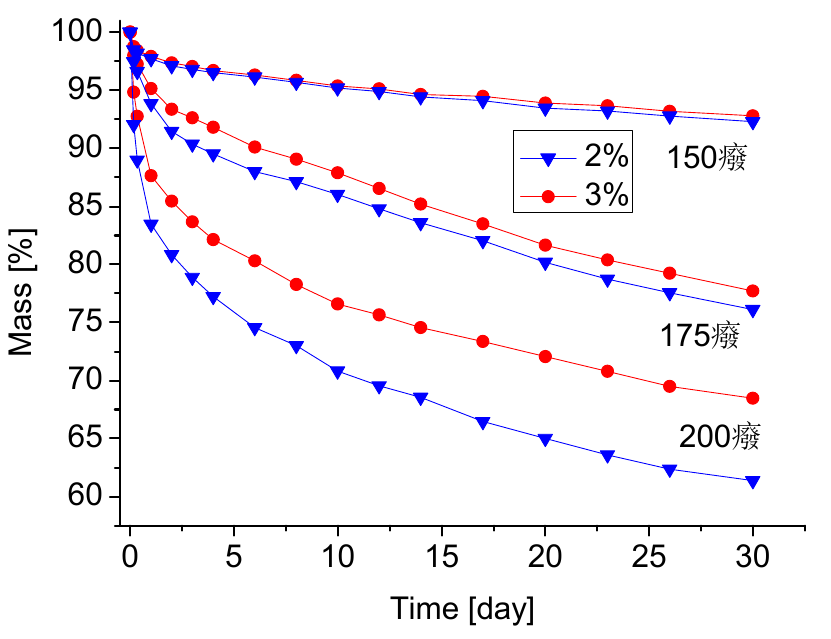
Figure 6. Thermal stability of the polyurethane foam as the mass loss after heating (non English characters represent degrees Celsius).